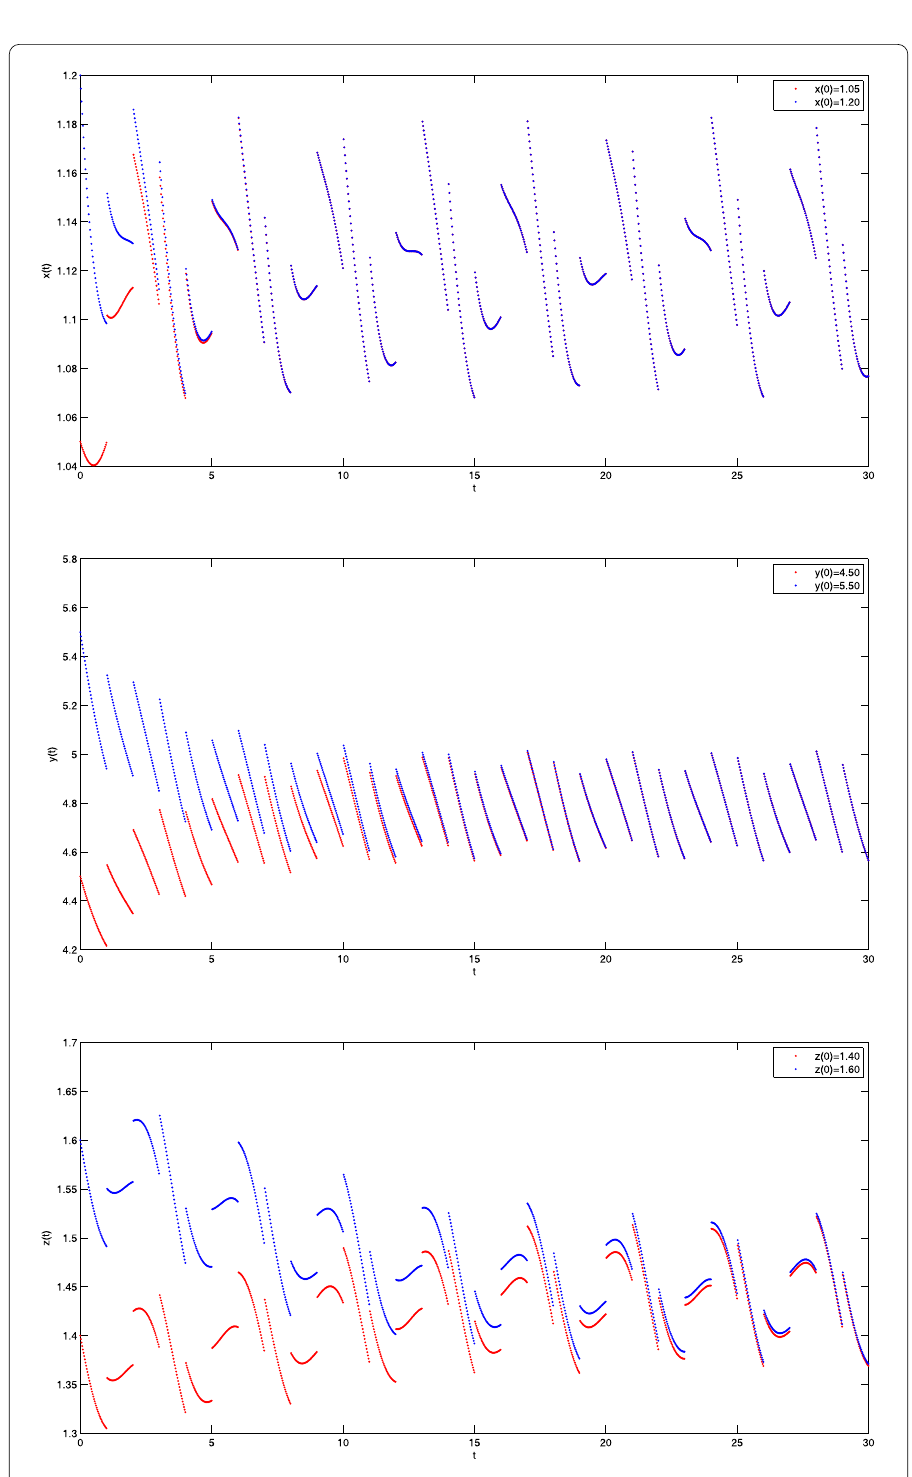
Figure 2 Time-series of the species in system (2) with Case 1: x 1 (0) = 1.05, y 1 (0) = 4.5, z 1 (0) = 1.4 and Case 2: